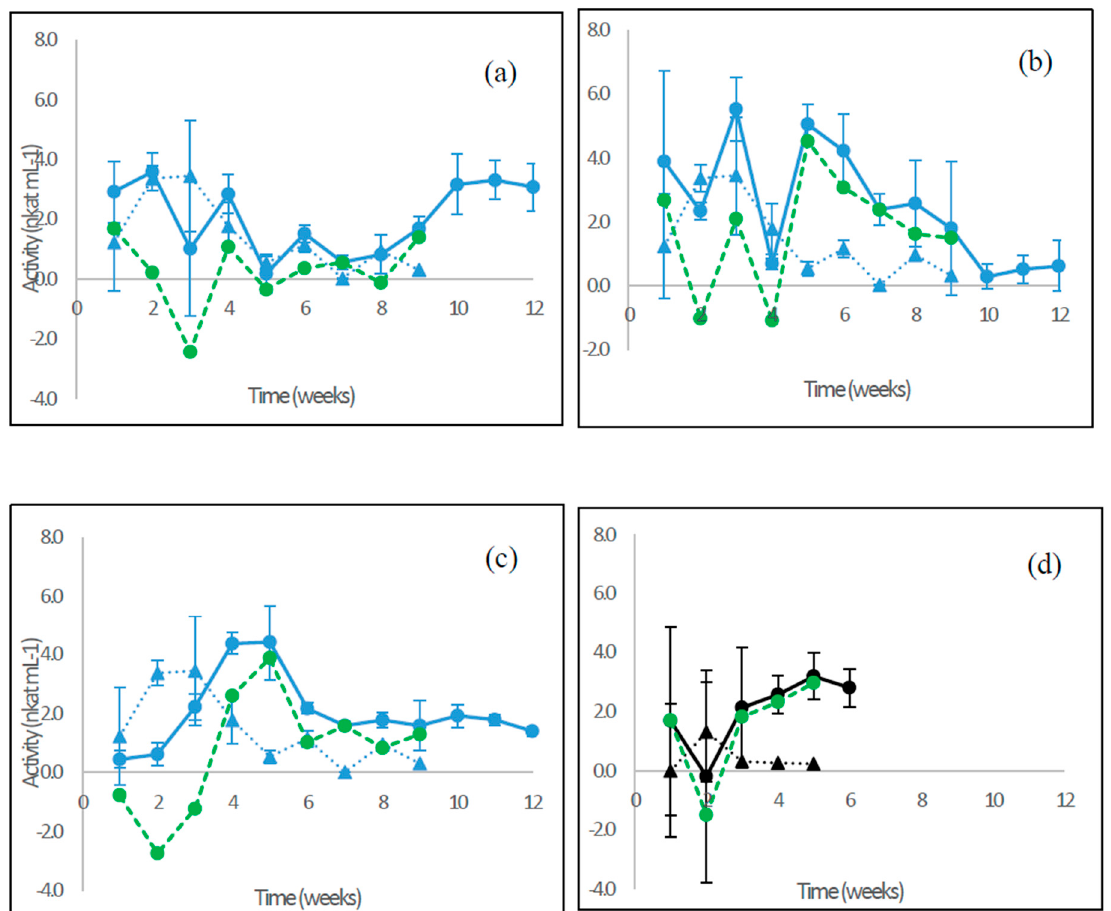
Figure 4. Endoglucanase activities produced by ( a ) the WR fungus P. radiata ; ( b ) the BR fungus F. pinicola ; ( c ) the GR fungus S. commune ; and ( d ) the LDF species C. cinerea . Fungal cultivations on birch wood (blue line with spheres) and on barley straw (black line with spheres). Values from control incubations of birch wood (blue triangles) and barley straw (black triangles) without fungi are included. Net activity values are also shown (green dotted lines) after subtracting the control activity. Mean value ( n = 3) is presented at each week time point. Bars indicate the standard error. Notice different scales in the y axis. For information on the fungi, see Table 1.